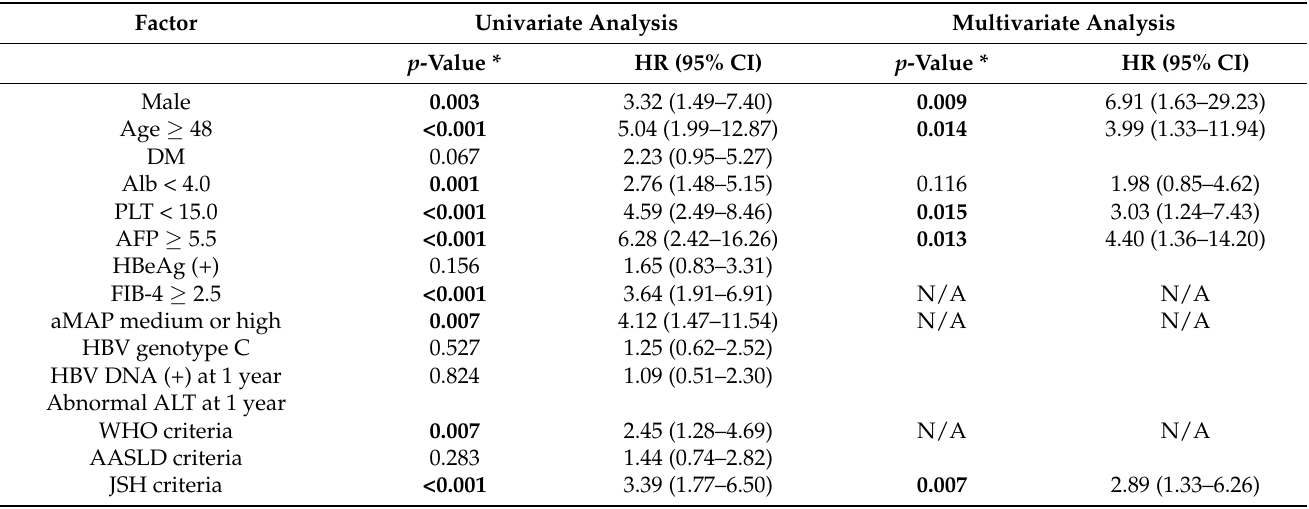
Figure 1. Cumulative incidences of hepatocellular carcinoma (HCC) and age–male–ALBI–platelets (aMAP) risk score in this study. ( a , b ) The incidences were estimated using the Kaplan–Meier method in an overall analysis ( a ) and patients were compared with a FIB-4 index ≥ 2.5 vs. <2.5. ( b , c ) Comparison of the aMAP risk score distribution between patients who developed HCC during the observation period and those who did not. Thick lines indicate medians and thin lines indicate interquartile ranges. ( d ) Cumulative incidences of HCC compared among the high-risk group of the aMAP risk score (>60), the medium-risk group (50–60) and the low-risk group (<50). A log-rank test was used to compare cumulative incidences. Table 2. Univariate and multivariate analysis of risk factors for the occurrence of HCC during NA